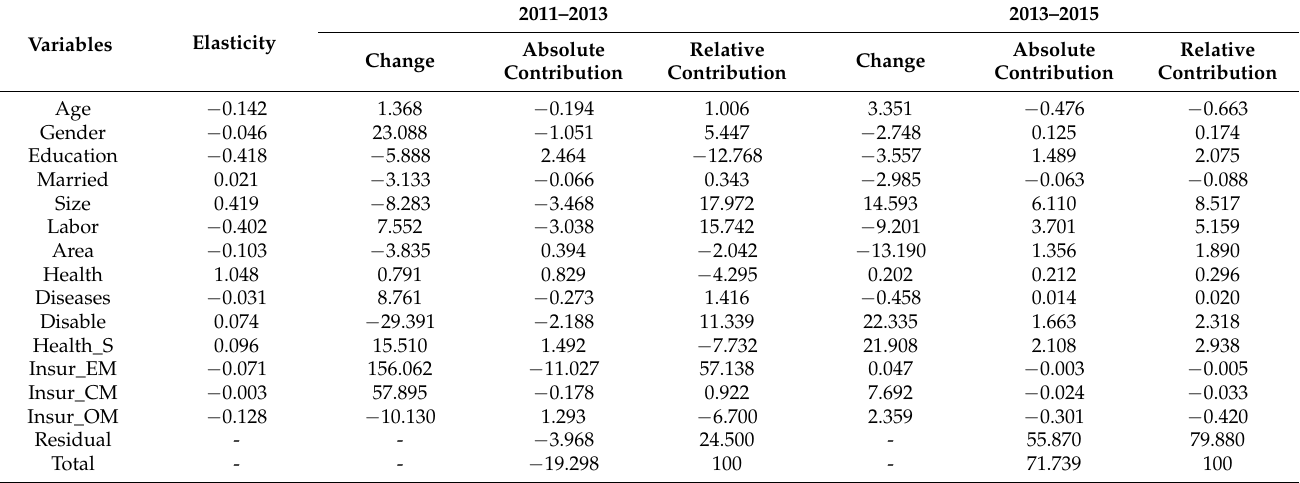
Table 7. Contribution of determinants to financial vulnerability changing for urban